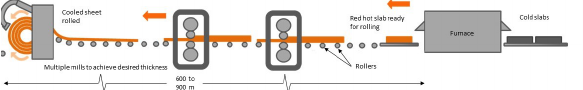
Figure 1. Schematic diagram showing the working of a hot-rolling steel mill.